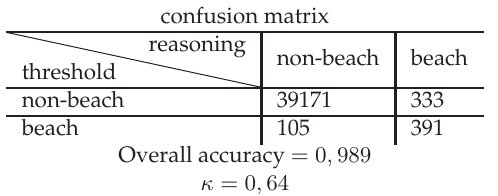
Table 6: Evaluation of expert B detection of beach segments in comparison to expert C